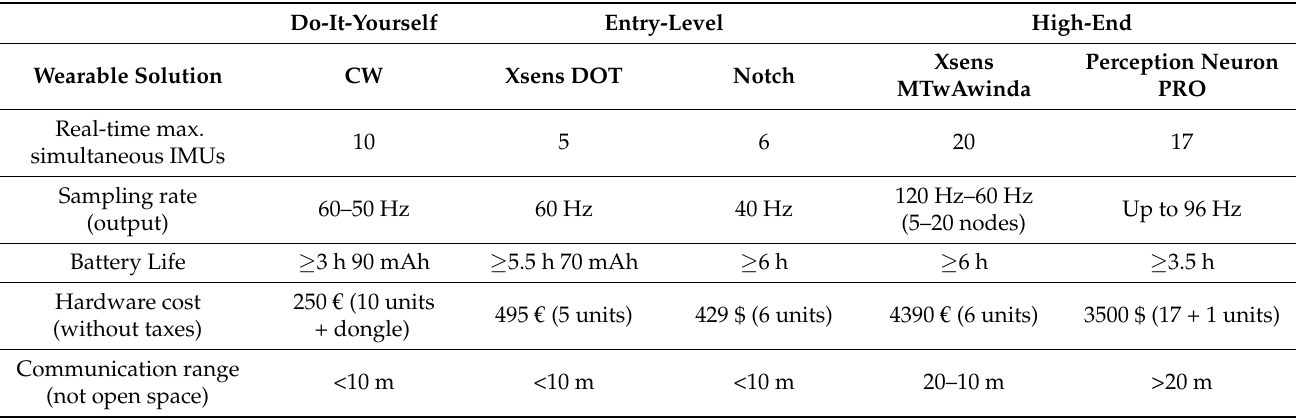
Table 3. Features of the proposed custom do-it-yourself system and other entry-level and high-end commercial